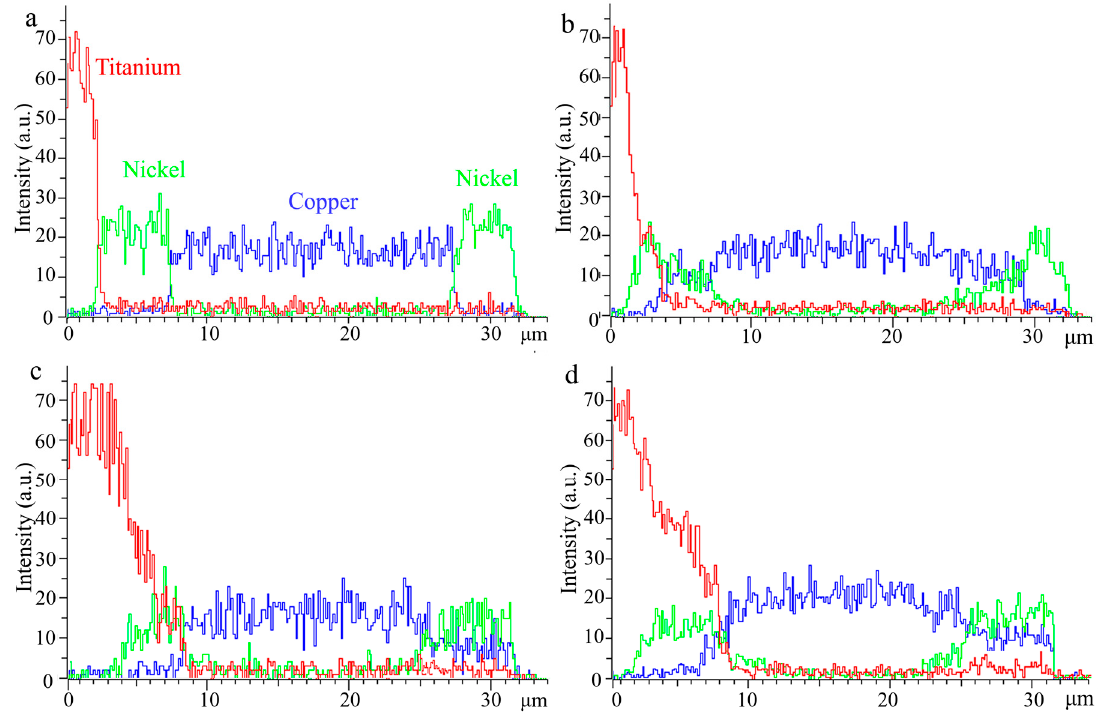
Figure 3. The elements line scan diagrams across the coatings from its substrate to the top after annealing: ( a ) untreated, ( b ) 600 °C, ( c ) 700 °C, and ( d ) 800 °C, respectively.